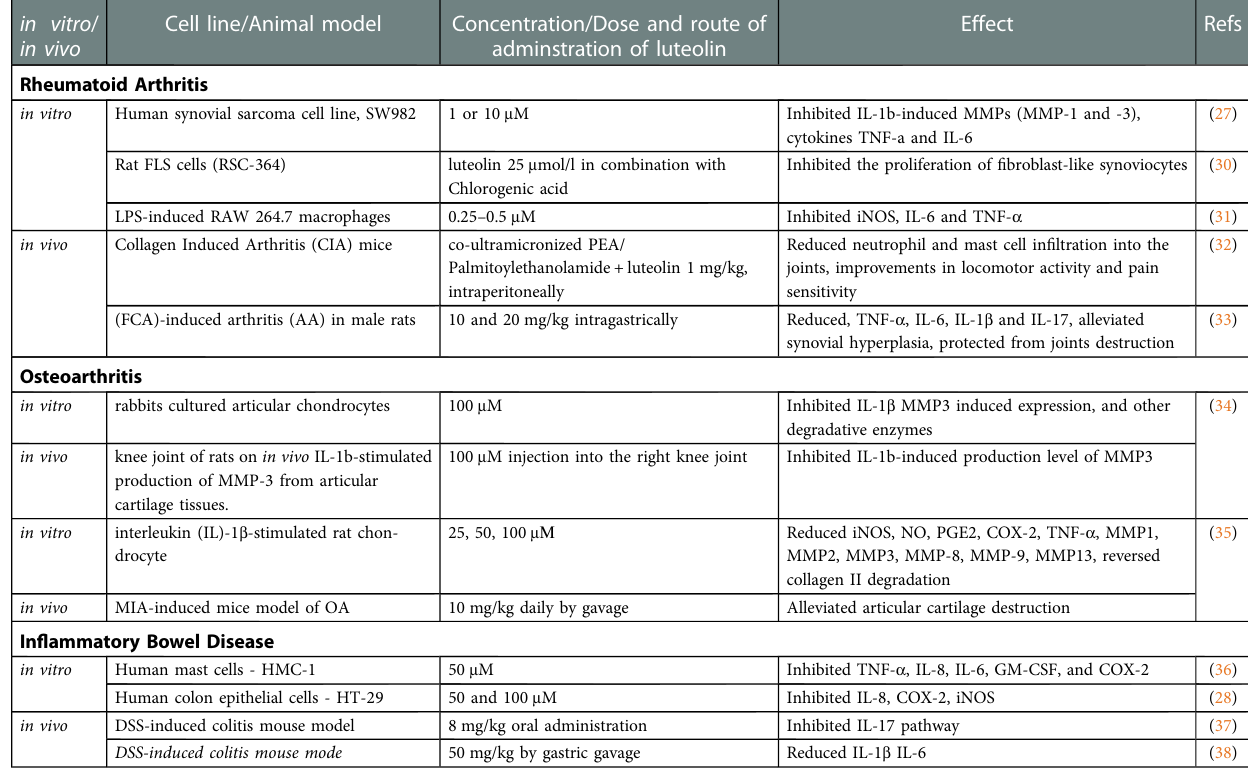
TABLE 3 Effects of luteolin on chronic in fl ammation as shown from in vitro and in vivo studies. in vitro / in